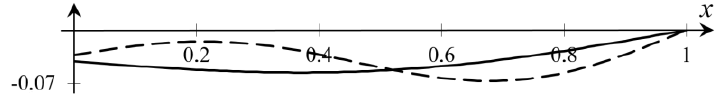
Figure 5. Graphs of 𝑄 1 (𝑥, 6) (solid line) and 𝑄 2 (𝑥, 6) (dashed line).